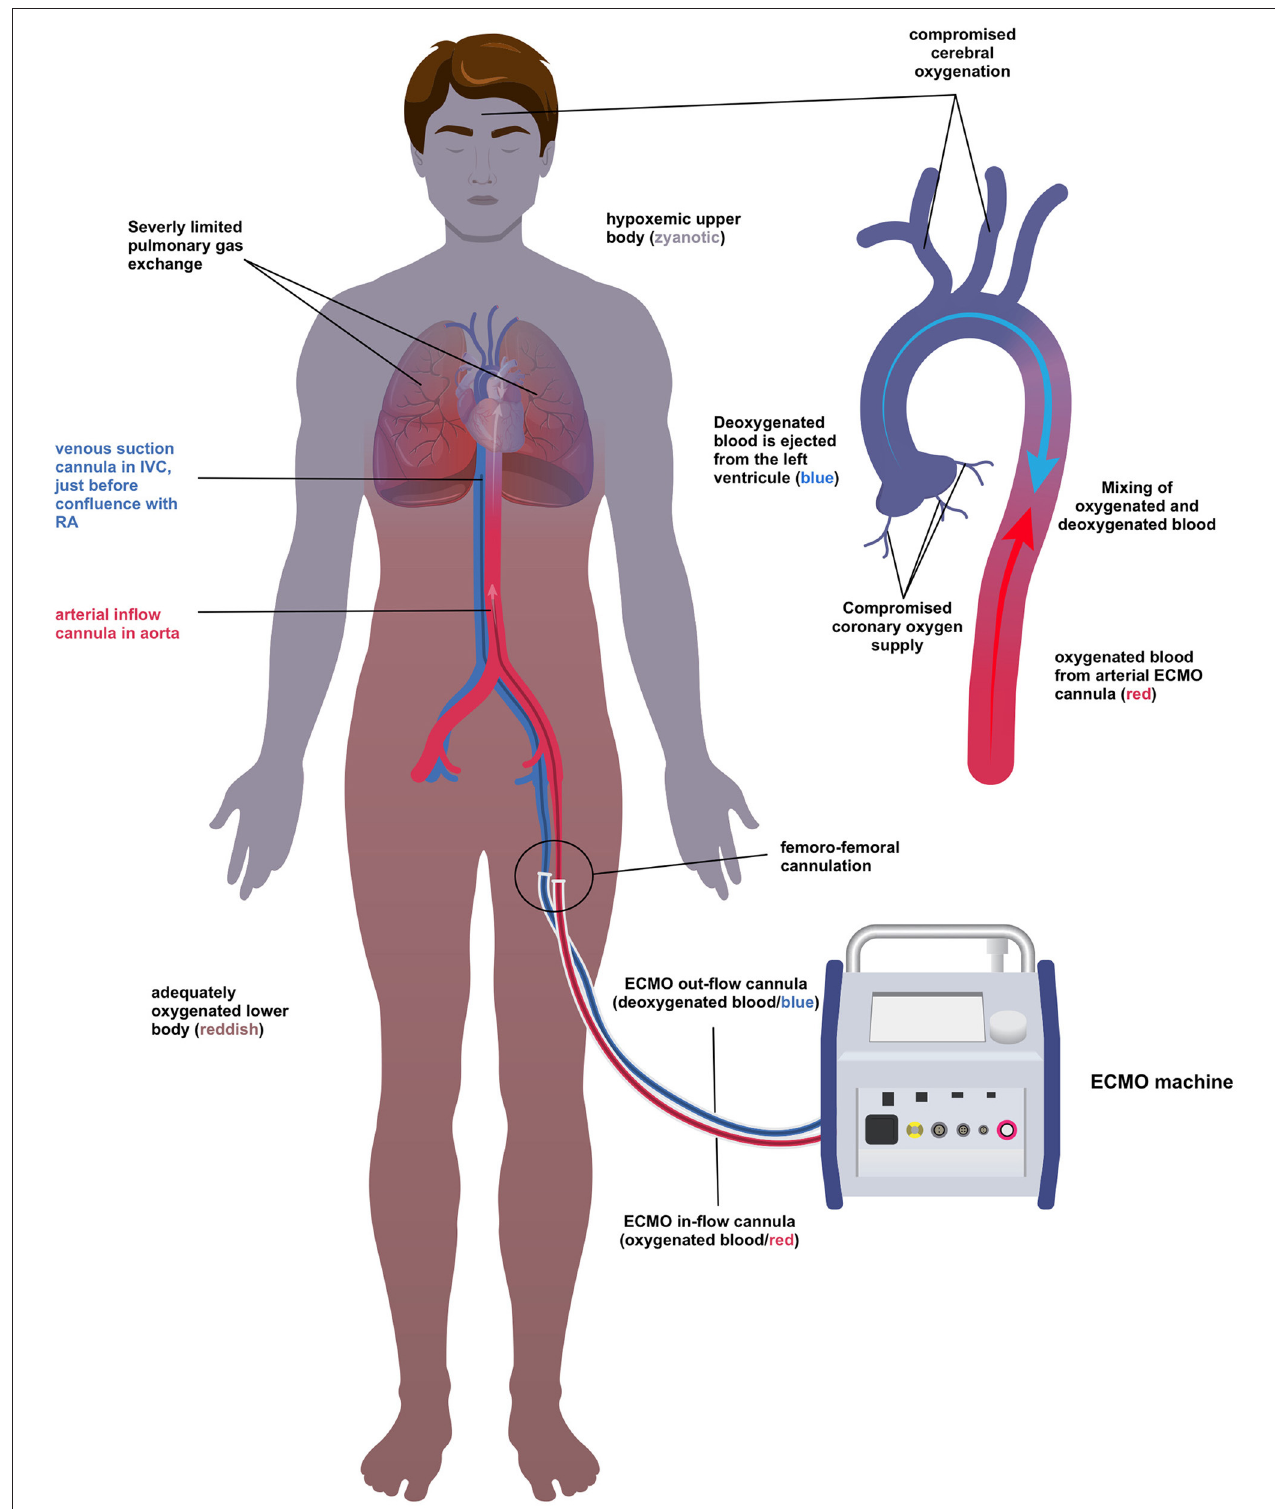
FIGURE 2 | Differential hypoxemia. ECMO, Extracorporeal membrane oxygenation; IVC, inferior vena cava; RA, right atrium.